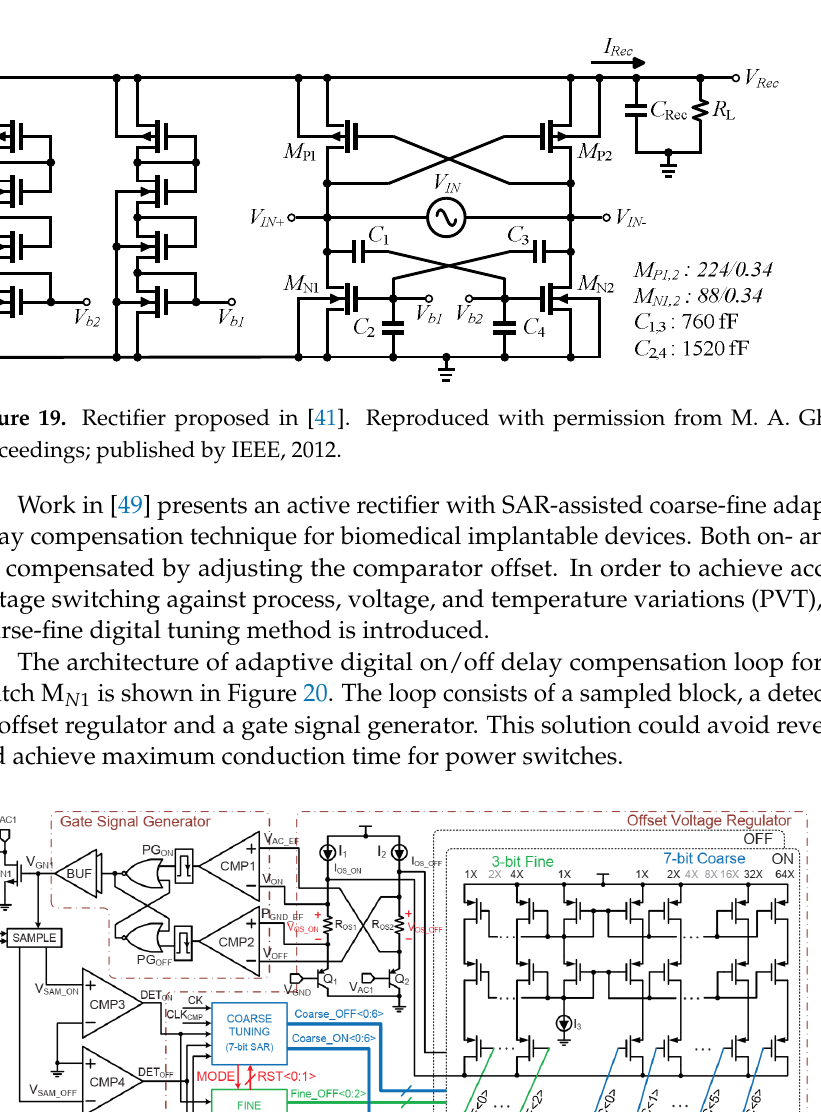
Figure 4. Active rectifier with voltage comparators.